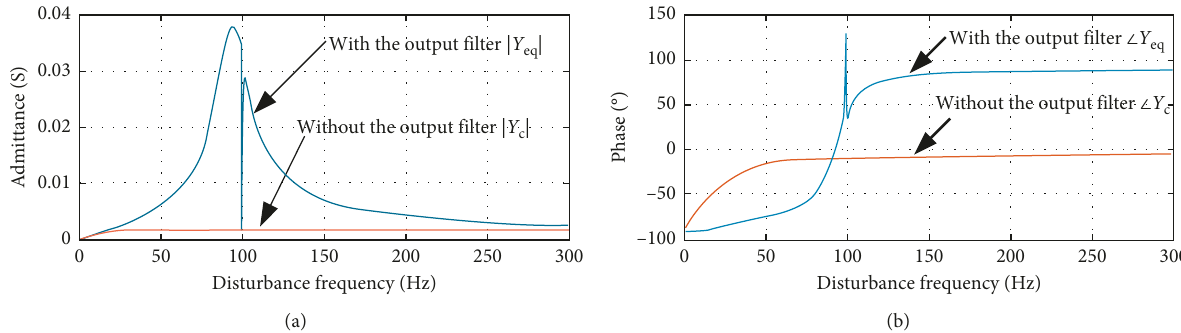
Figure 10: Characteristic of equivalent admittance (harmonic model) of the converter for the study case of Tables 1 and 2. (a) Magnitude of admittance. (b) Phase angle of admittance.